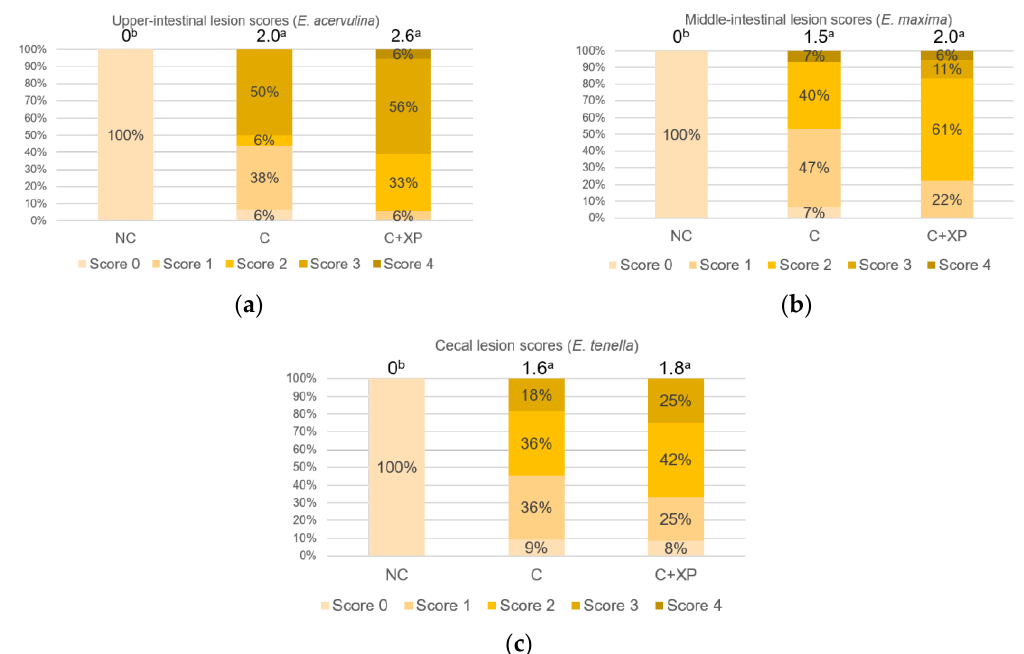
challenged and supplemented with xylanase and protease treatment.